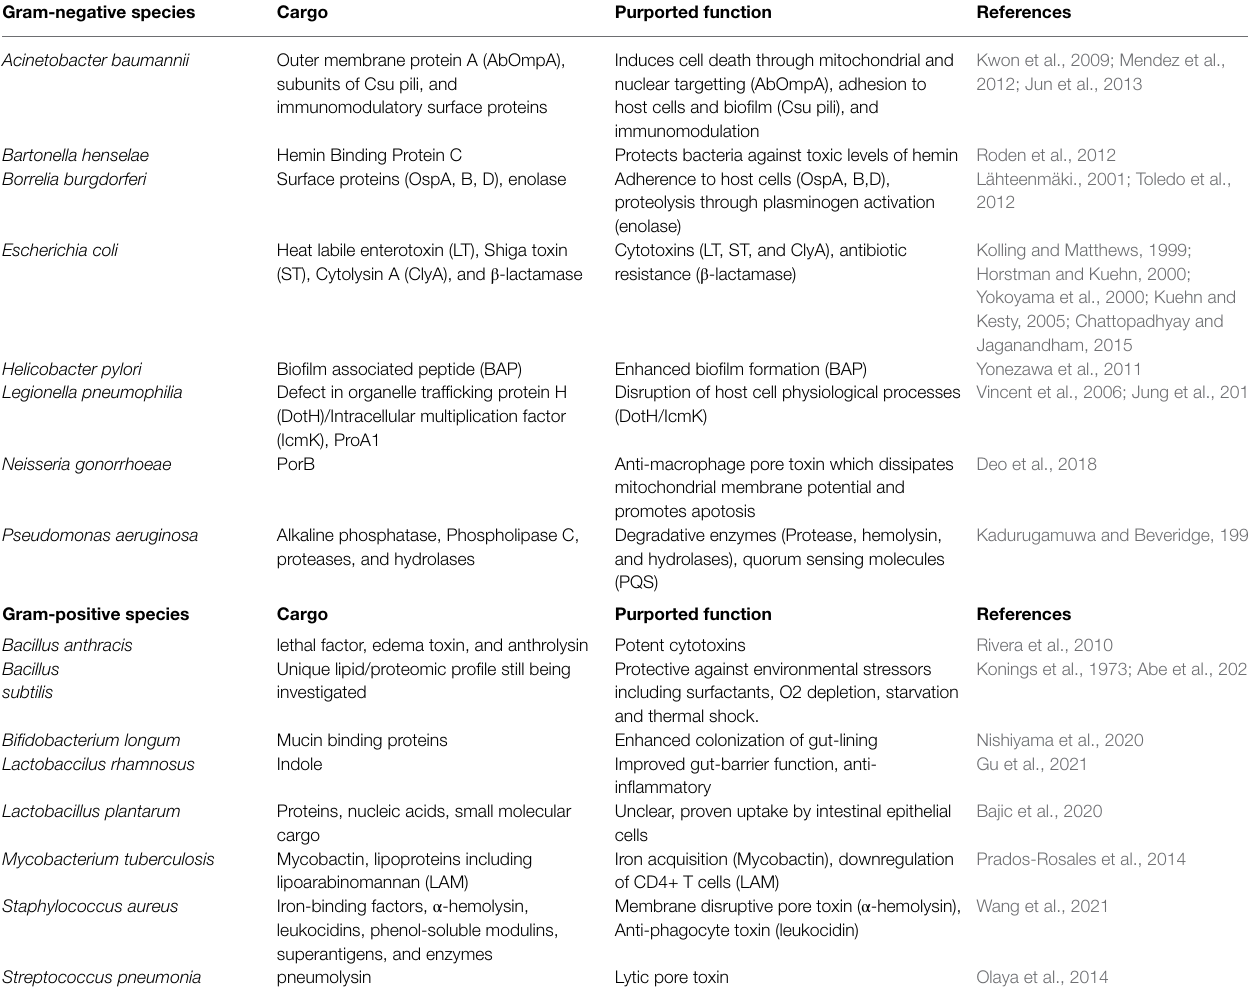
TABLE 1 | Reported examples of cargo transported by bacterial membrane